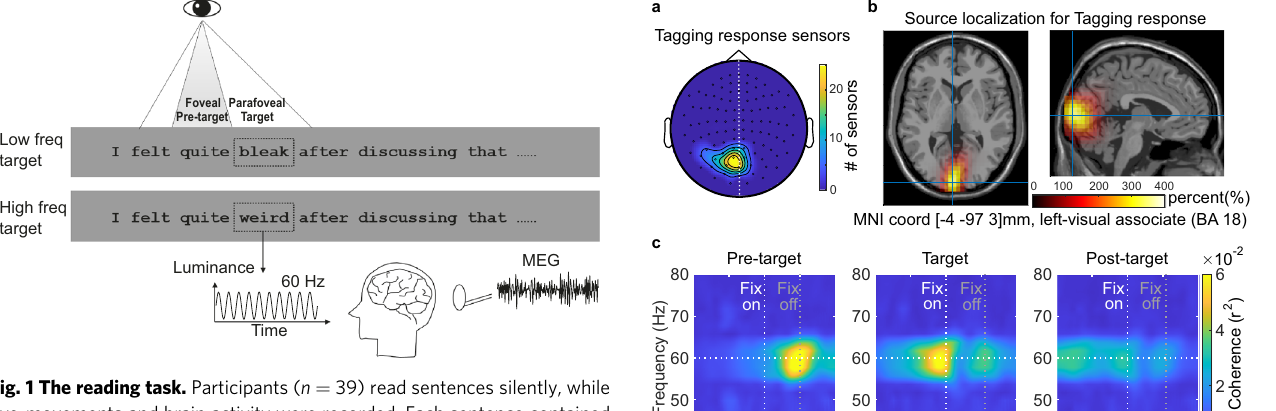
when fi xating on the pre-target word (see Supplementary Fig. 4